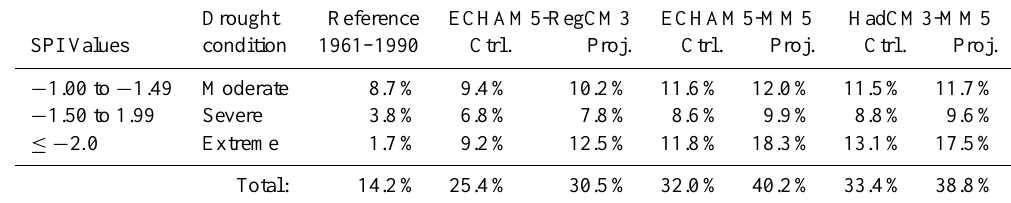
Table 2. The percentage of time with moderate, severe and extreme drought conditions as derived with the 6-month SPI. The values are standardized according to the reference period 1961–1990 (observed